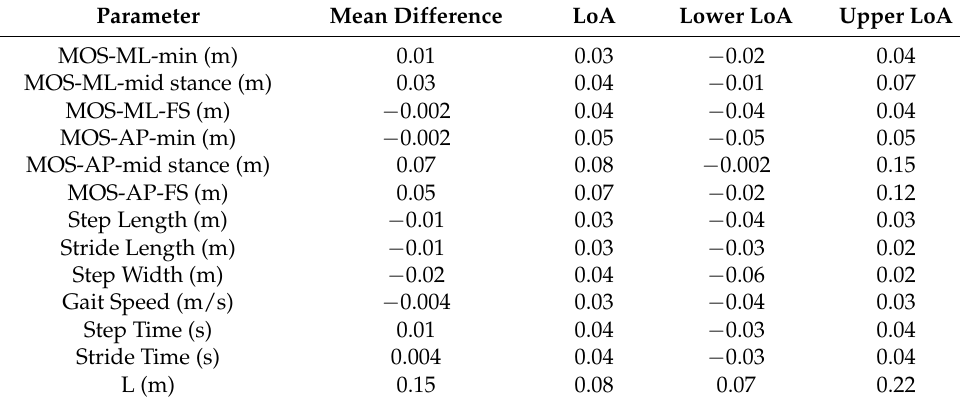
Table 4. Results of Bland–Altman analysis of agreement between gait parameters calculated from the Kinect and Motion